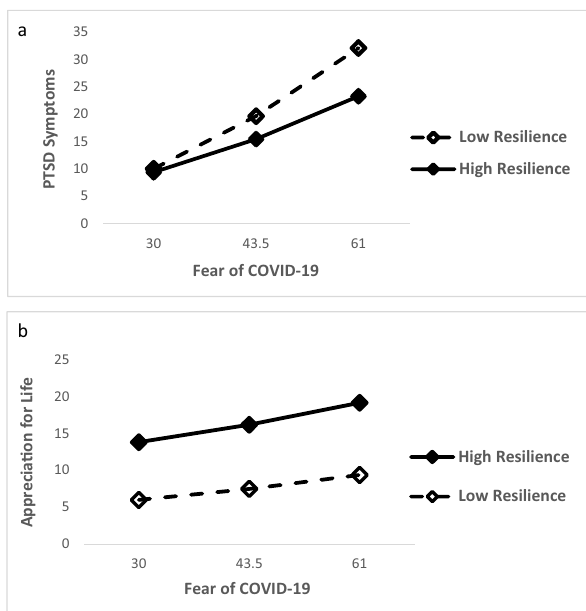
Figure 1: Trait resilience moderates the relationship between COVID - 19 fear with both ( a ) post - traumatic stress and ( b ) and post - traumatic